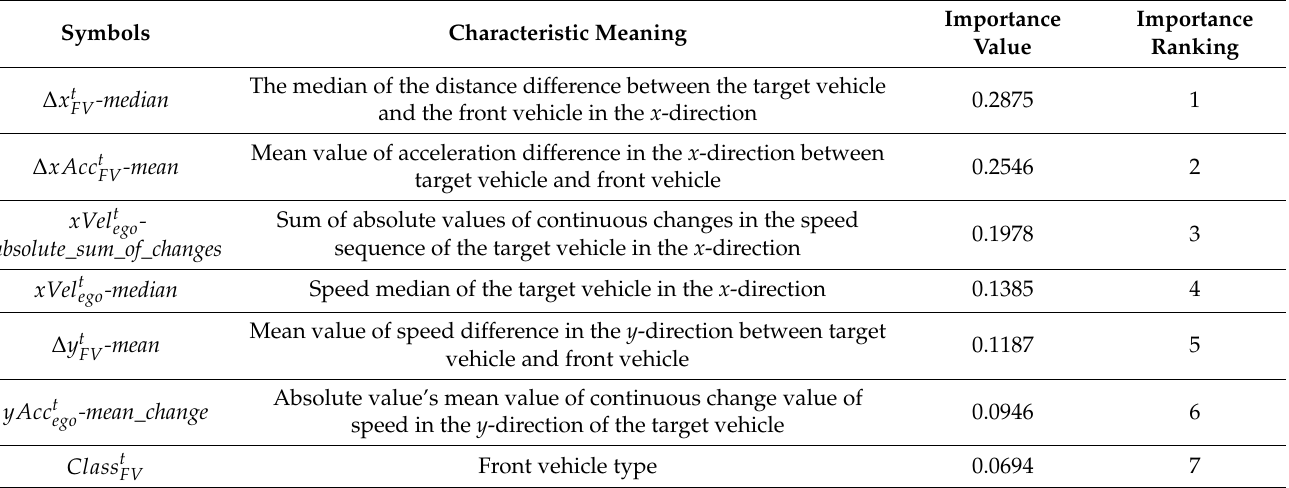
Table 5. RFECV Feature